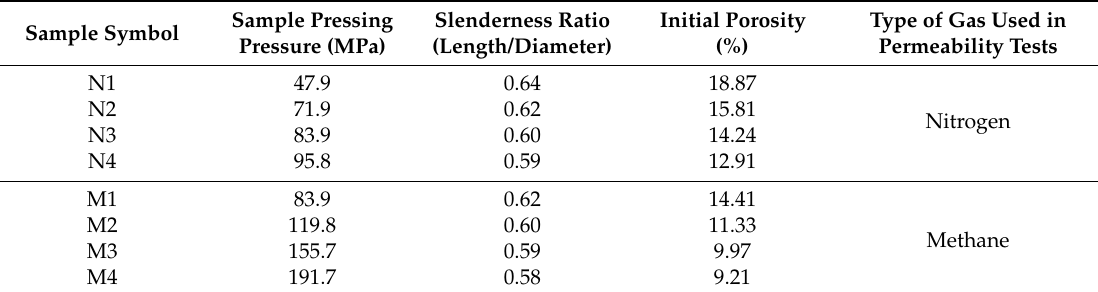
Table 2. Properties of the coal